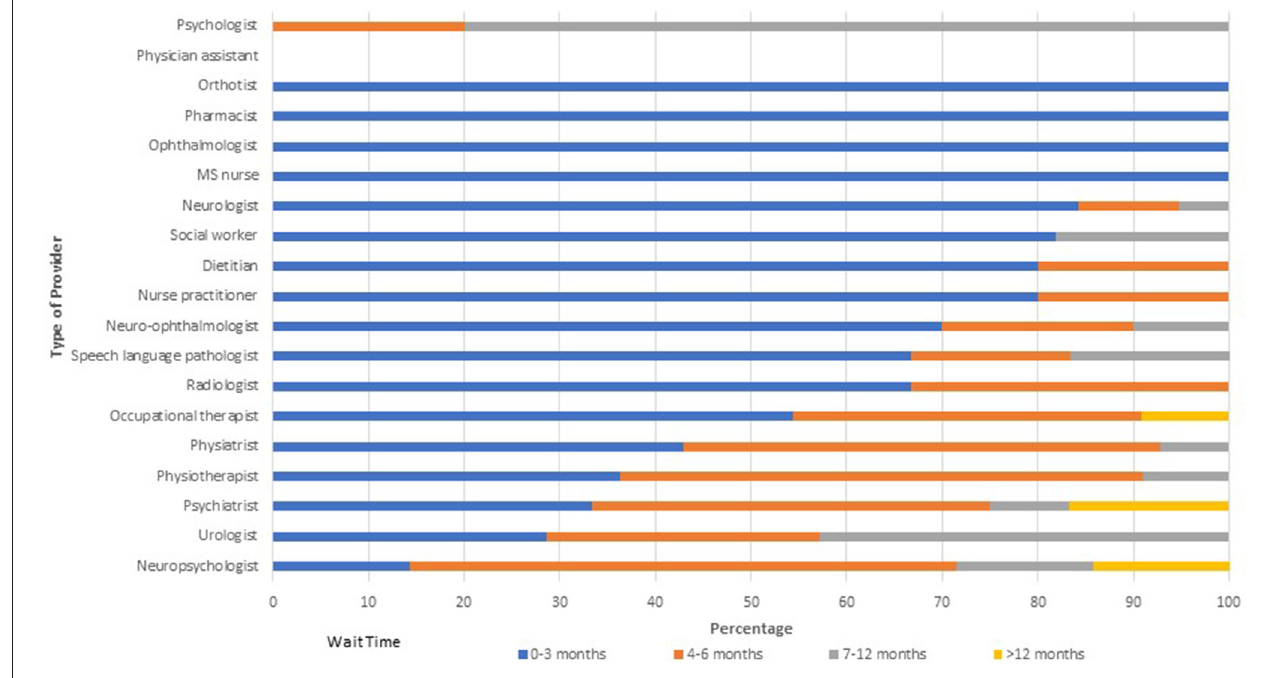
FIGURE 1 | Wait times for providers within multiple sclerosis